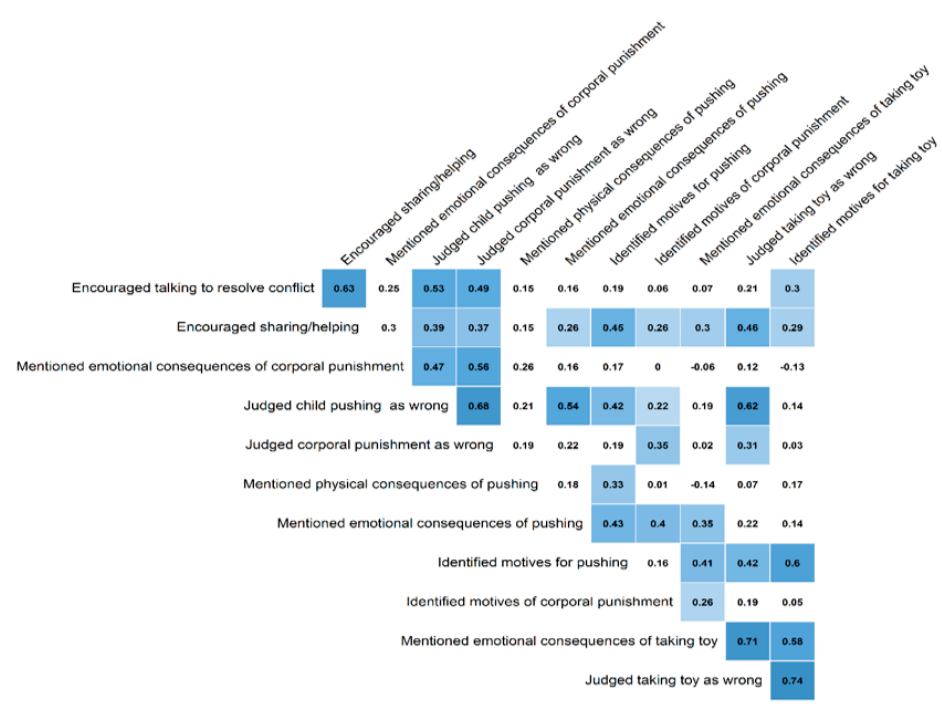
Figure 2. Tetrachoric correlation matrix of the 12 binary items used in the exploratory factor analysis. Note: Blue squares represent significant positive correlations. Darker colour tones represent larger correlation coefficients. White squares represent non-significant correlation coefficients at p < 0.05.